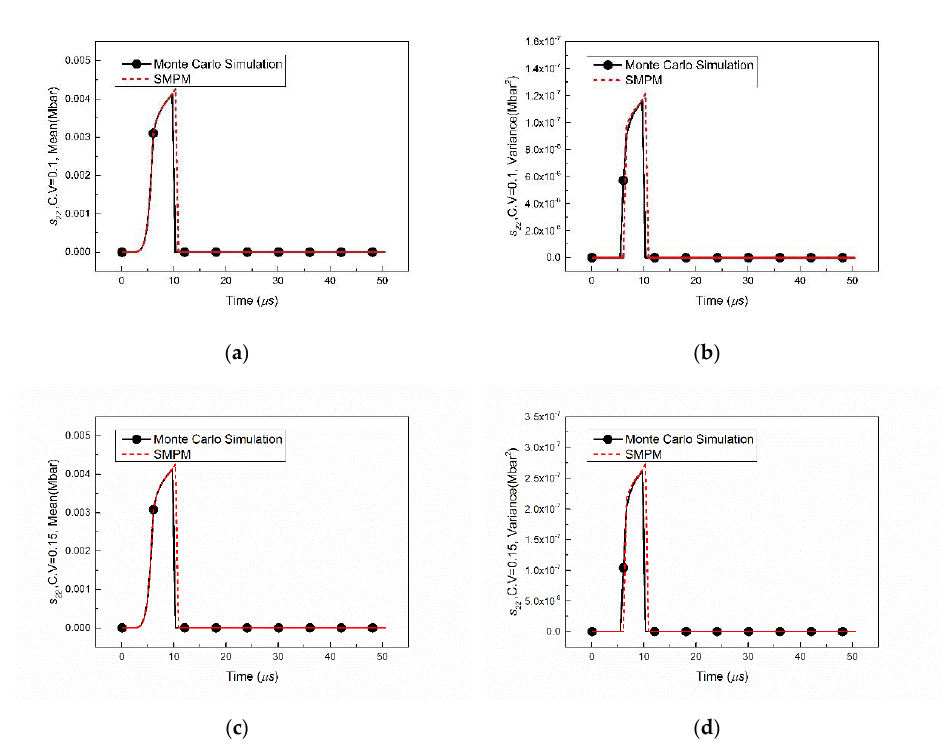
Figure 12. Deviatoric stress S 22 response of location G by various methods with C.V = 0.1 and C.V = 0.15: ( a ) Mean of S 22 with C.V = 0.1; ( b ) Variance of S 22 with C.V = 0.1; ( c ) Mean of S 22 with C.V = 0.15; ( d ) Variance of S 22 with C.V = 0.15 .